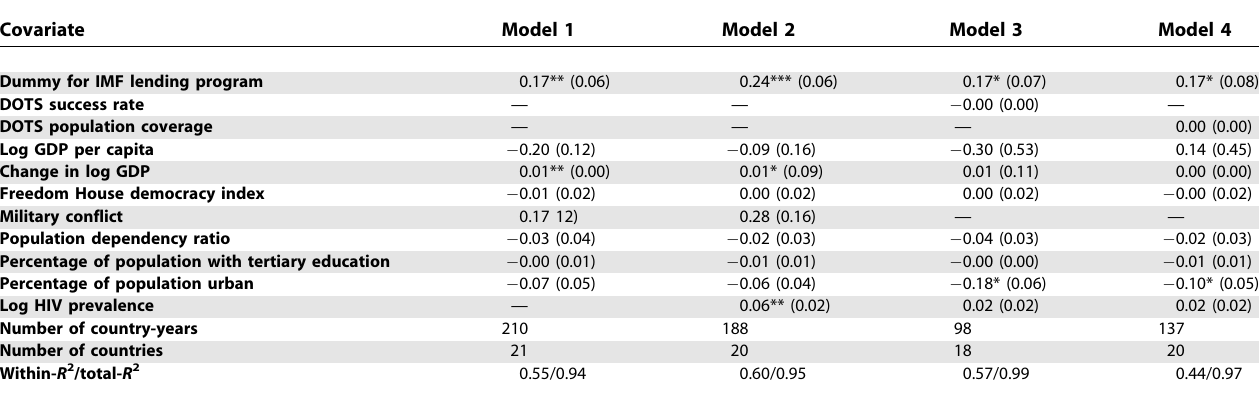
Table 1. Associations of IMF Lending Programs with Log Tuberculosis Mortality Rates